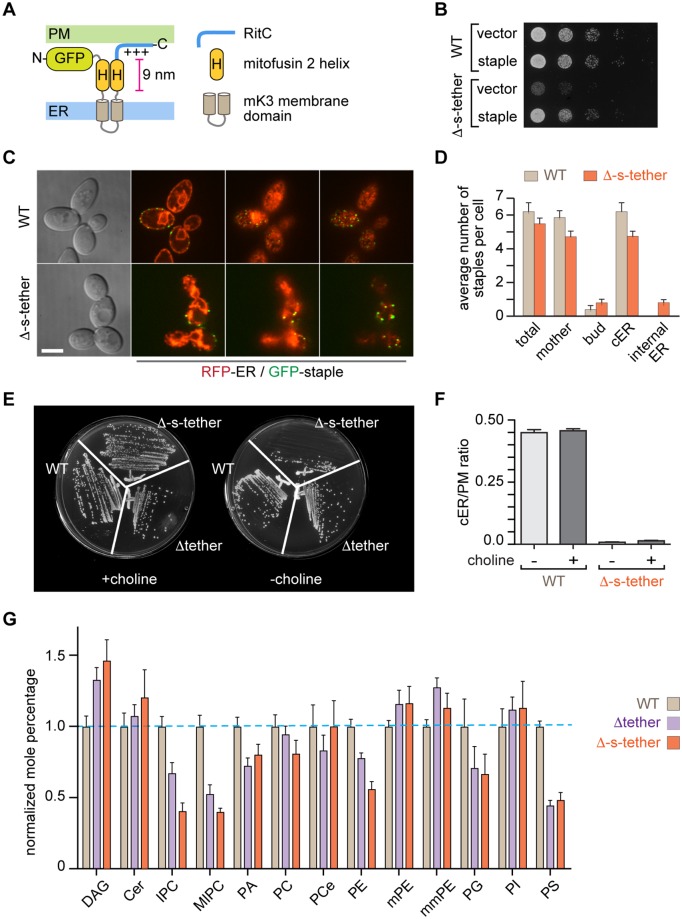
Slow growth of Δ-s-tether cells is rescued by expression of an artificial ER-PM tether or choline.A. The “ER-PM staple" has a modular architecture consisting of an N-terminal GFP, an ER anchor comprising two transmembrane domains and a lumenal loop from herpes virus (MVH68) mK3 E3 ubiquitin ligase, two helices from mitofusin 2 that are predicted to adopt an antiparallel arrangement about 9 nm long, and the polybasic domain from RitC that targets the PM. B. Tenfold serial dilutions of WT (SEY6210) and Δ-s-tether (CBY5838) cells, transformed with either the vector control (YCplac111) or a plasmid expressing the artificial staple (pCB1185), spotted on solid growth medium, and incubated for 2 d at 30 °C. C. DIC images of WT and Δ-s-tether cells and the corresponding spinning disc confocal fluorescence microscopy images showing the colocalization of RFP-ER (pCB1024) and the GFP-marked artificial staple (pCB1185) at three different optical focal planes. Scale bar = 5 μm. D. Quantification of the staple distribution within mother and buds and at cER versus internal cytoplasmic ER. E. Choline-dependent growth of Δ-s-tether cells. WT, Δtether (ANDY198), and Δ-s-tether (CBY5838) cells were streaked onto solid growth medium supplemented with 1 mM choline chloride, as indicated, and incubated for 3 d at 30 °C. F. Quantification of ER-RFP localization in WT and Δ-s-tether cells, with and without 1 mM choline, represented as a ratio of the length of PM-associated ER per circumference of PM in each cell (n > 50 cells; error bars represent SEM). G. Lipid composition of WT, Δtether, and Δ-s-tether cells represented as a normalized mole percentage relative to WT (set to 1.0). The data represent the mean ± SEM derived from the analysis of five independent samples. Numerical data presented in this figure may be found in S1 Data. Δ-s-tether, Δ-super-tether; cER, cortical ER; DAG, diacylglycerol; DIC, differential interference contrast; ER, endoplasmic reticulum; GFP, green fluorescent protein; IPC, inositol-phosphoceramide; MIPC, mannosylinositol phosphoceramide; mmPE, dimethyl PE; mPE, monomethyl PE; PA, phosphatidic acid; PC, phosphatidylcholine; PCe, ether phosphatidylcholine; PE, phosphatidylethanolamine; PG, phosphatidylglycerol; PI, phosphatidylinositol; PM, plasma membrane; PS, phosphatidylserine; RFP, red fluorescent protein, RitC; C-terminal polybasic region from mammalian Rit1; WT, wild type.